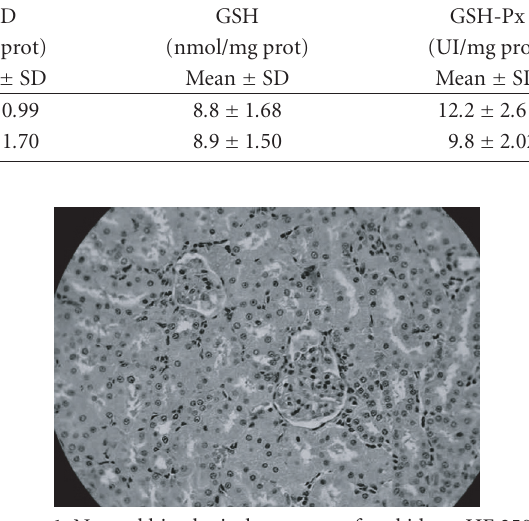
Figure 1. Normal histological structure of rat kidney. HE